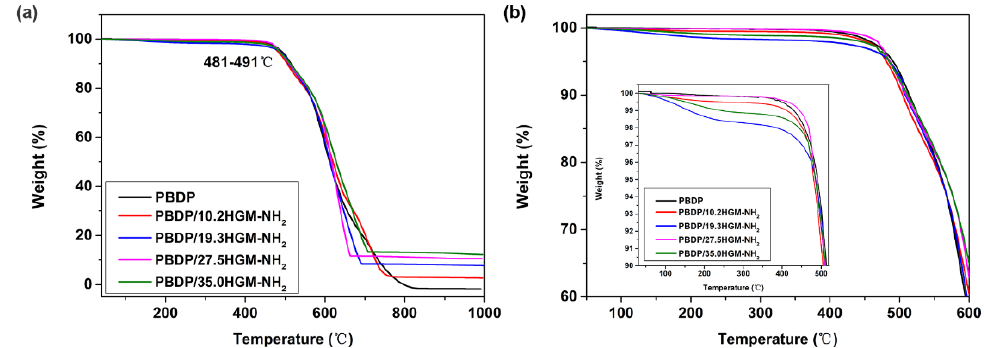
Figure 7. ( a ) TG curves of the neat PBDP and PBDP/HGM-NH 2 composites, ( b ) extended view of TG curve with weight loss of 60~100% and enlarged view of with weight loss of 90~100%. Table 1. Thermal-characteristic data of the PBDP/HGM-NH 2 composites. Samples